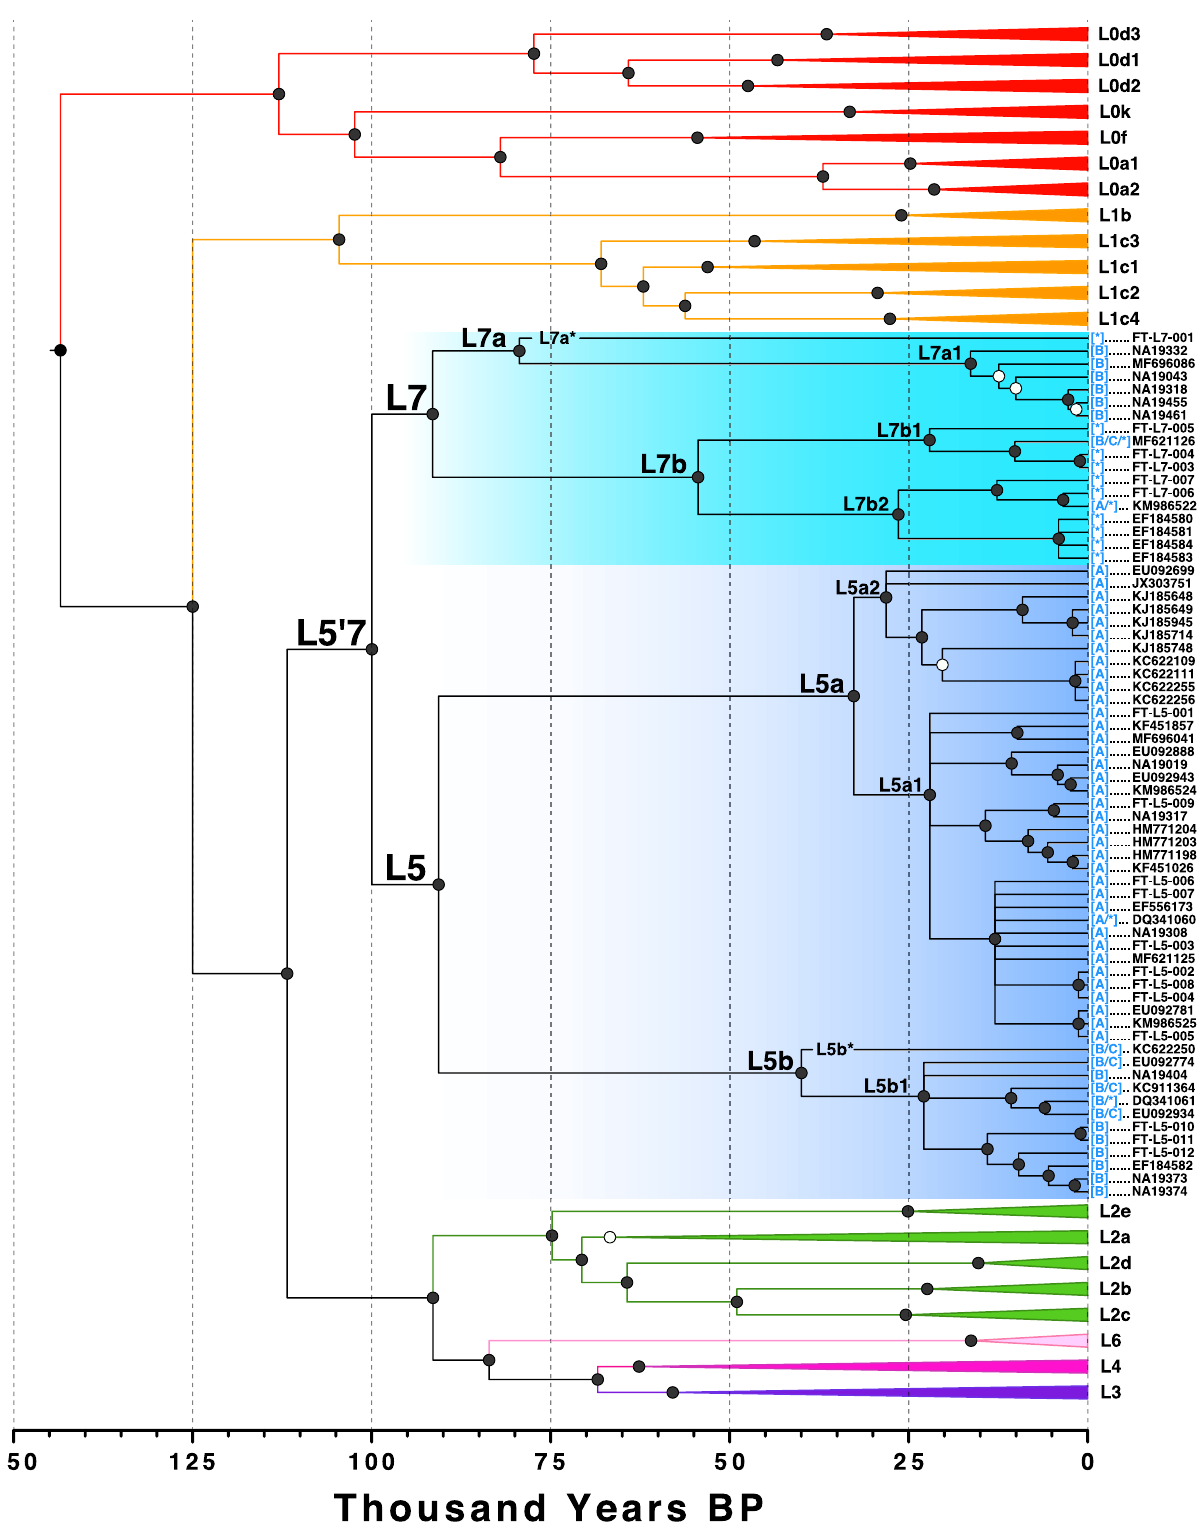
Figure 2. Ultrametric Time Tree. Mean divergence times estimated by BEAST with a fixed clock of 2.285 × 10 − 8 substitutions site −1 year −1 are shown. L5'7 clades are highlighted in blue. Black circles denote clades with ≥ 0.9 posterior probability, open circles denote clades with ≥ 0.5 but < 0.9 posterior probability, and polytomies include any clades < 0.5 posterior probability. Previous haplogroup assignments (in square brackets) are denoted as follows: * = L5, A = L5a, B = L5b, C = L5c (which is an undescribed